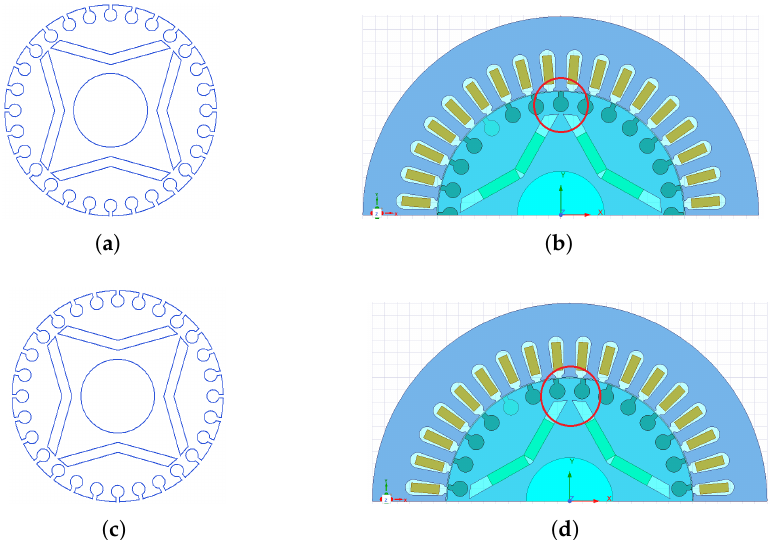
Figure 13. Geometry conversion bug found in ANSYS Electronics Desktop. ( a ) ANSYS RMxprt geometry (PM thickness 4.58mm); ( b ) generated ANSYS Maxwell model for ( a ); ( c ) ANSYS RMxprt geometry (PM thickness 4.59mm); ( d ) generated ANSYS Maxwell model for ( c ).